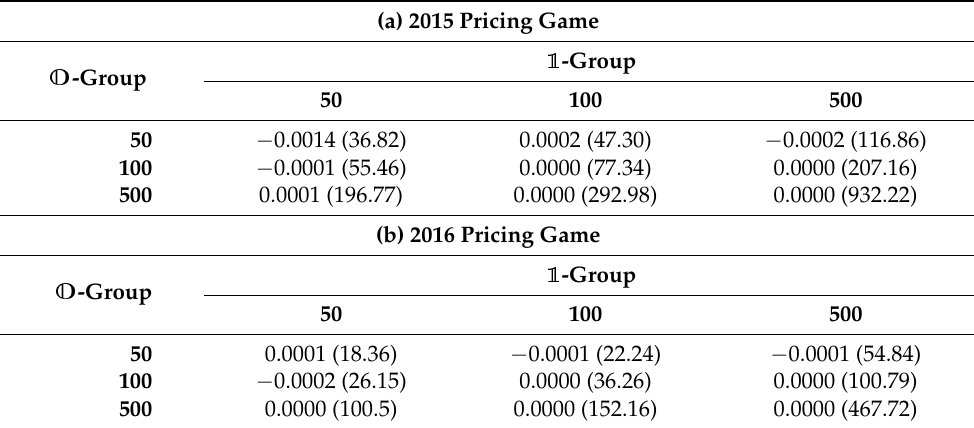
Table 7. Bias and run time (s), the latter between brackets, for the approximation ˆC the 2015 and 2016 pricing game dataset. This is given for the weighted-mean-plot approach and for several different numbers of clusters for the O - and 1 -group.